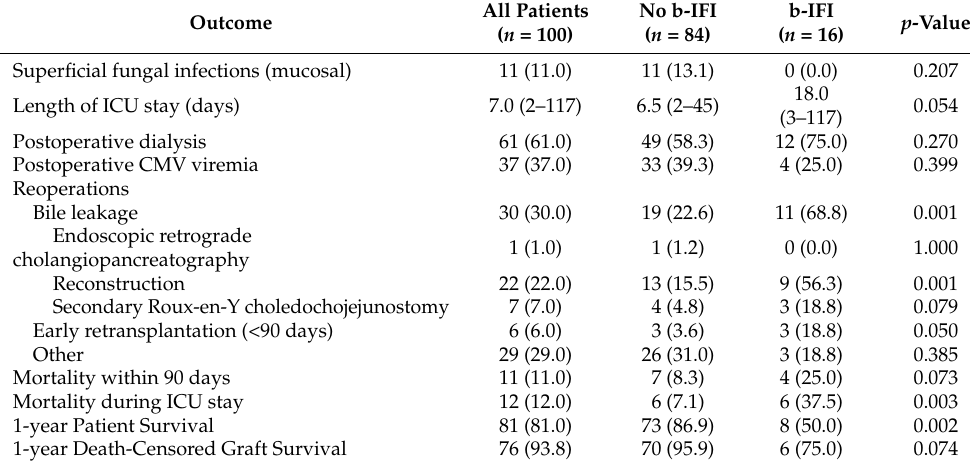
Table 5. Postoperative outcome ( n =